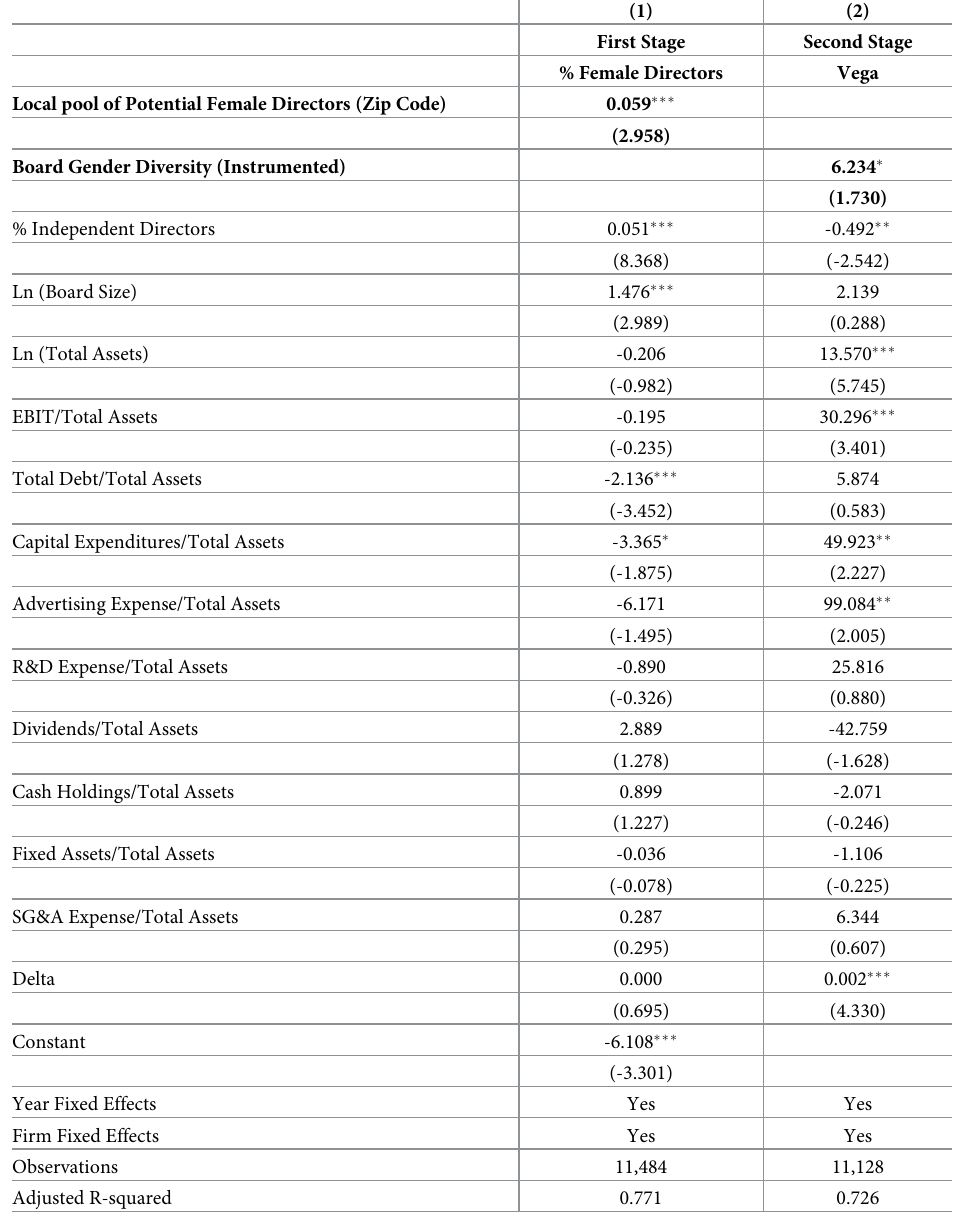
Table 5. Instrumental-variable analysis using a geographic pool of female directors as instrument based on zip